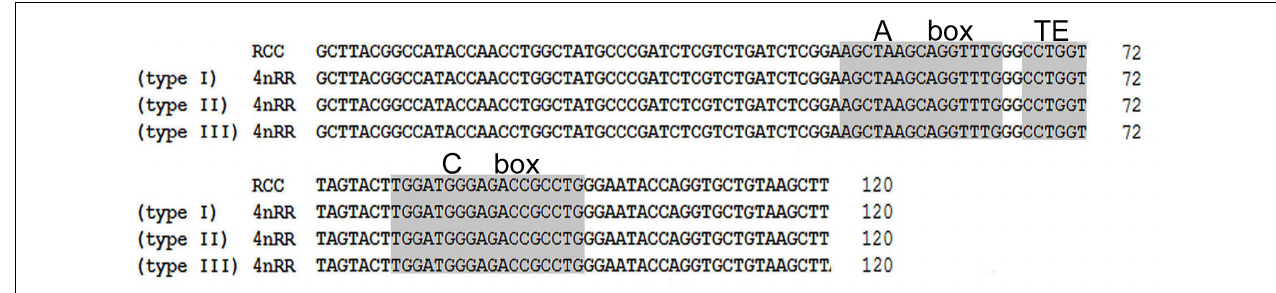
FIGURE 3 | Comparison of 5S coding regions from RCC and 4 n RR. Internal control regions of the coding region are shaded.